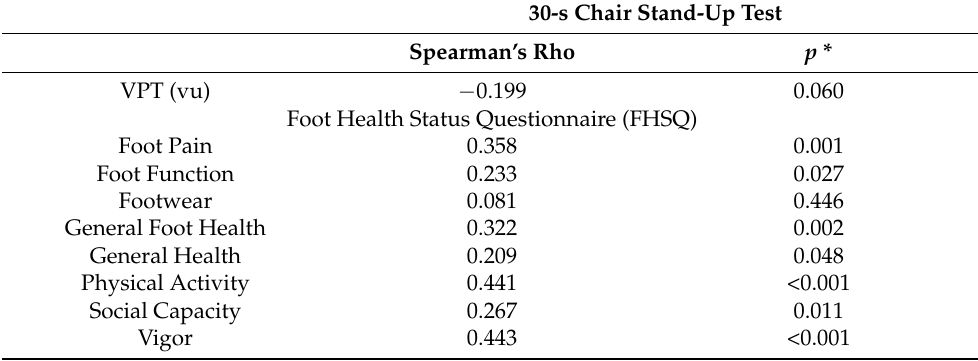
Table 2. Correlations between the 30-s chair stand-up test and the vibration perception threshold (VPT) and the Foot Health Status Questionnaire (FHSQ) dimensions in the type 2 diabetes mellitus population ( n = 90).